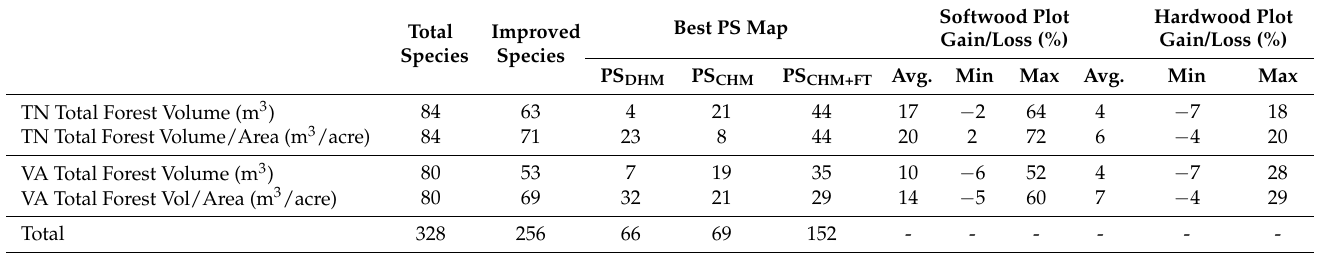
Table 6. Post-stratified estimation results by FIA species